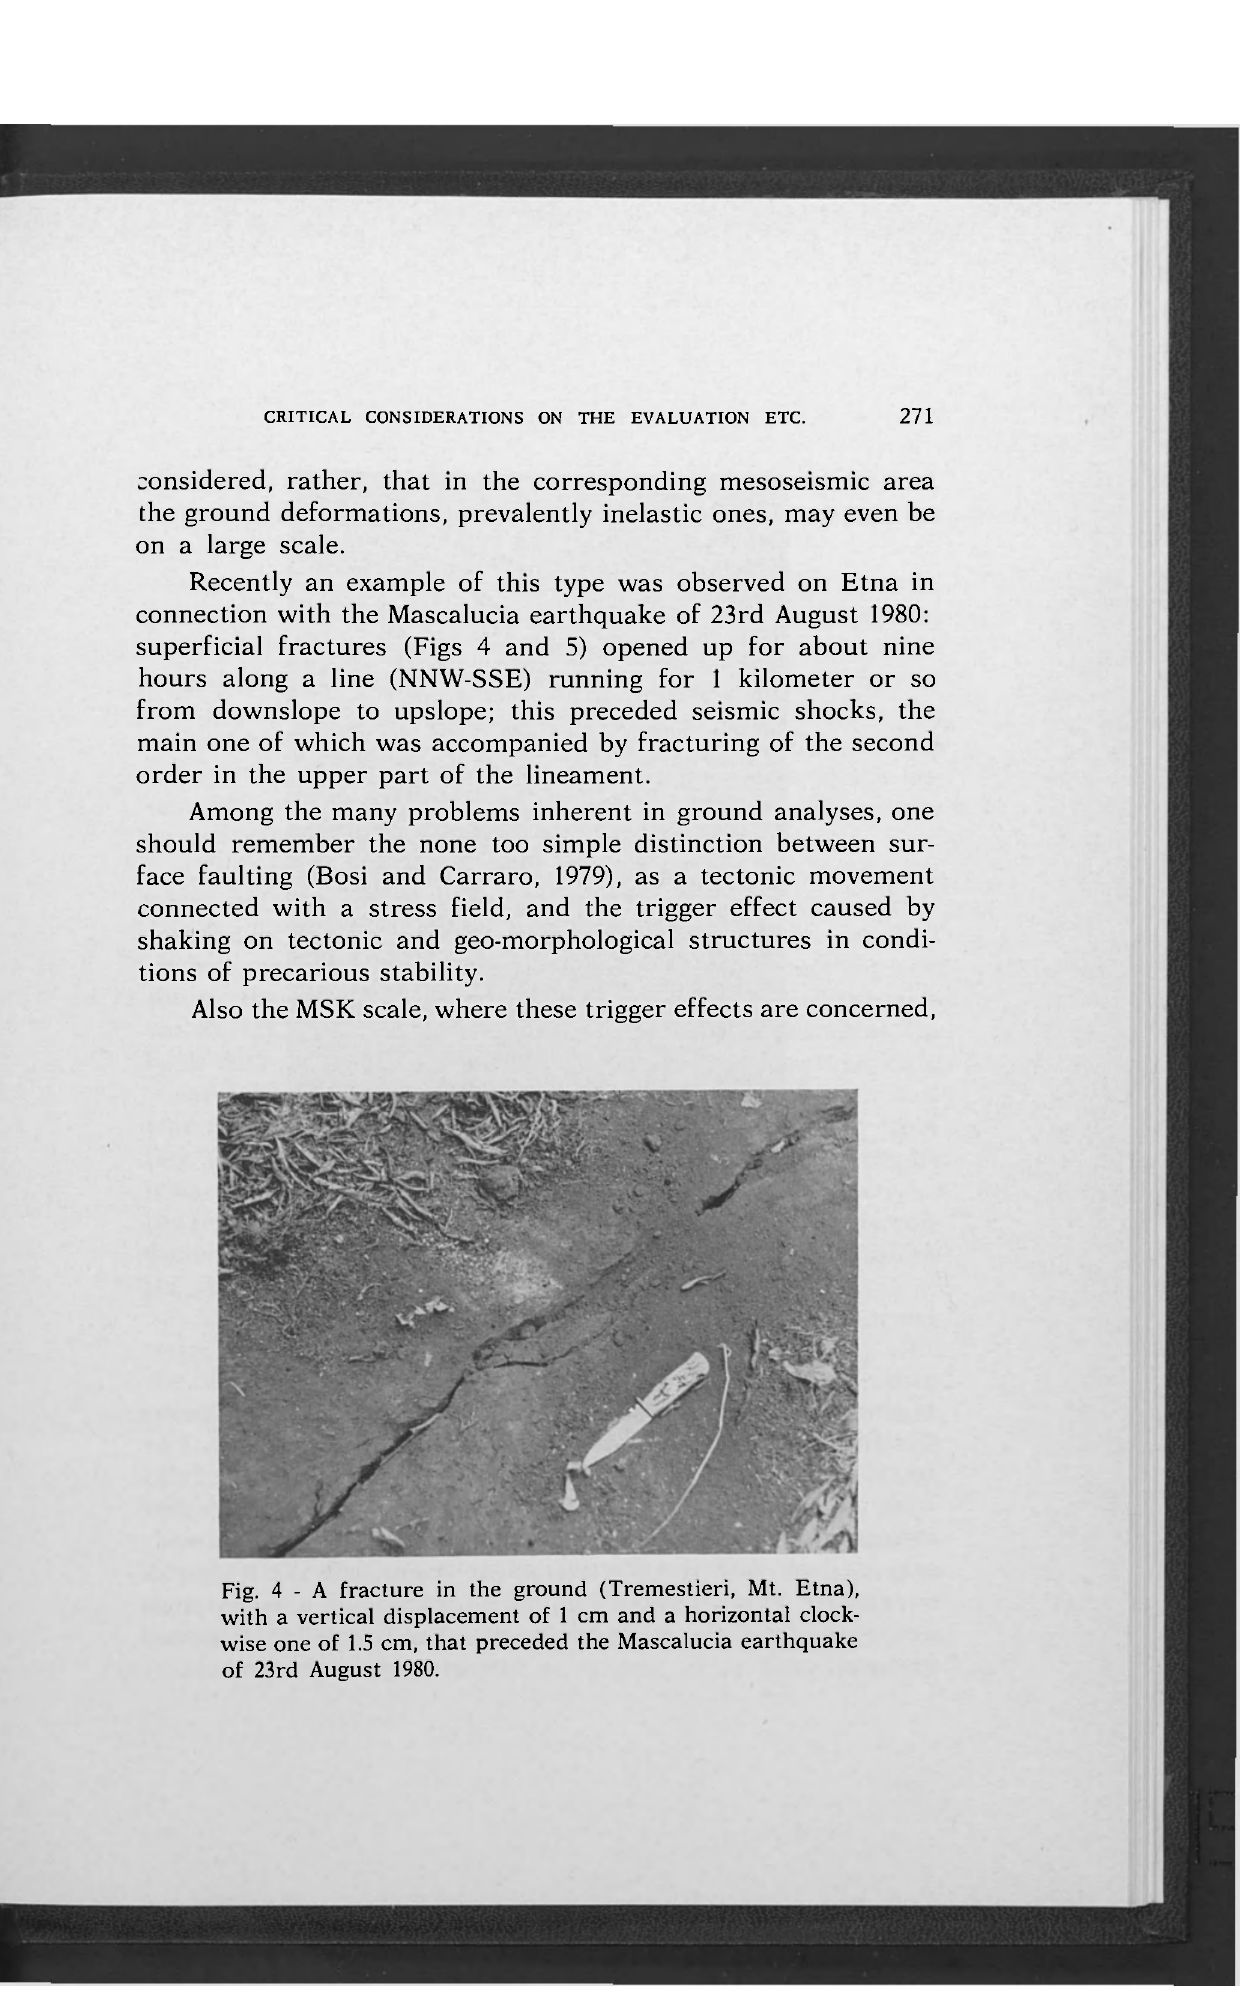
Fig. 4 - A fracture in the ground (Tremestieri, Mt. Etna), with a vertical displacement of 1 cm and a horizontal clock- wise one of 1.5 cm, that preceded the Mascalucia earthquake of 23rd August